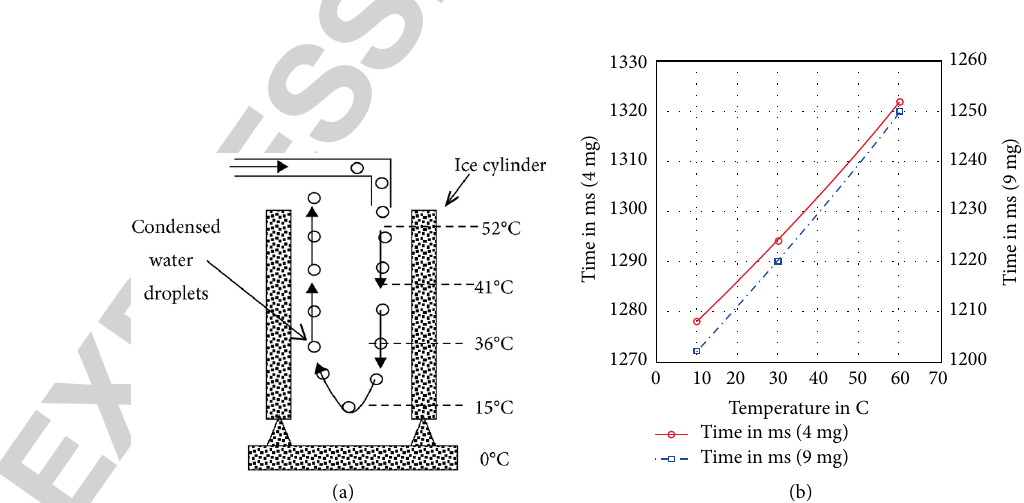
Figure 3: Results from the Manuscript 3 [4]. (a) Motion of condensed water droplets in the ice cylinder where the environment supports no convection currents. (b) Time-of-fall of water droplet increases with the increase in droplet temperature. Time-of-fall of two water droplets in a 5.913 m long metal tube was measured. Temperature of droplets was changed from 10°C to 60°C. Time delays of 44 ms and 48 ms were measured for 4 mg and 9 mg droplets for the temperature range of 10°C–60°C,